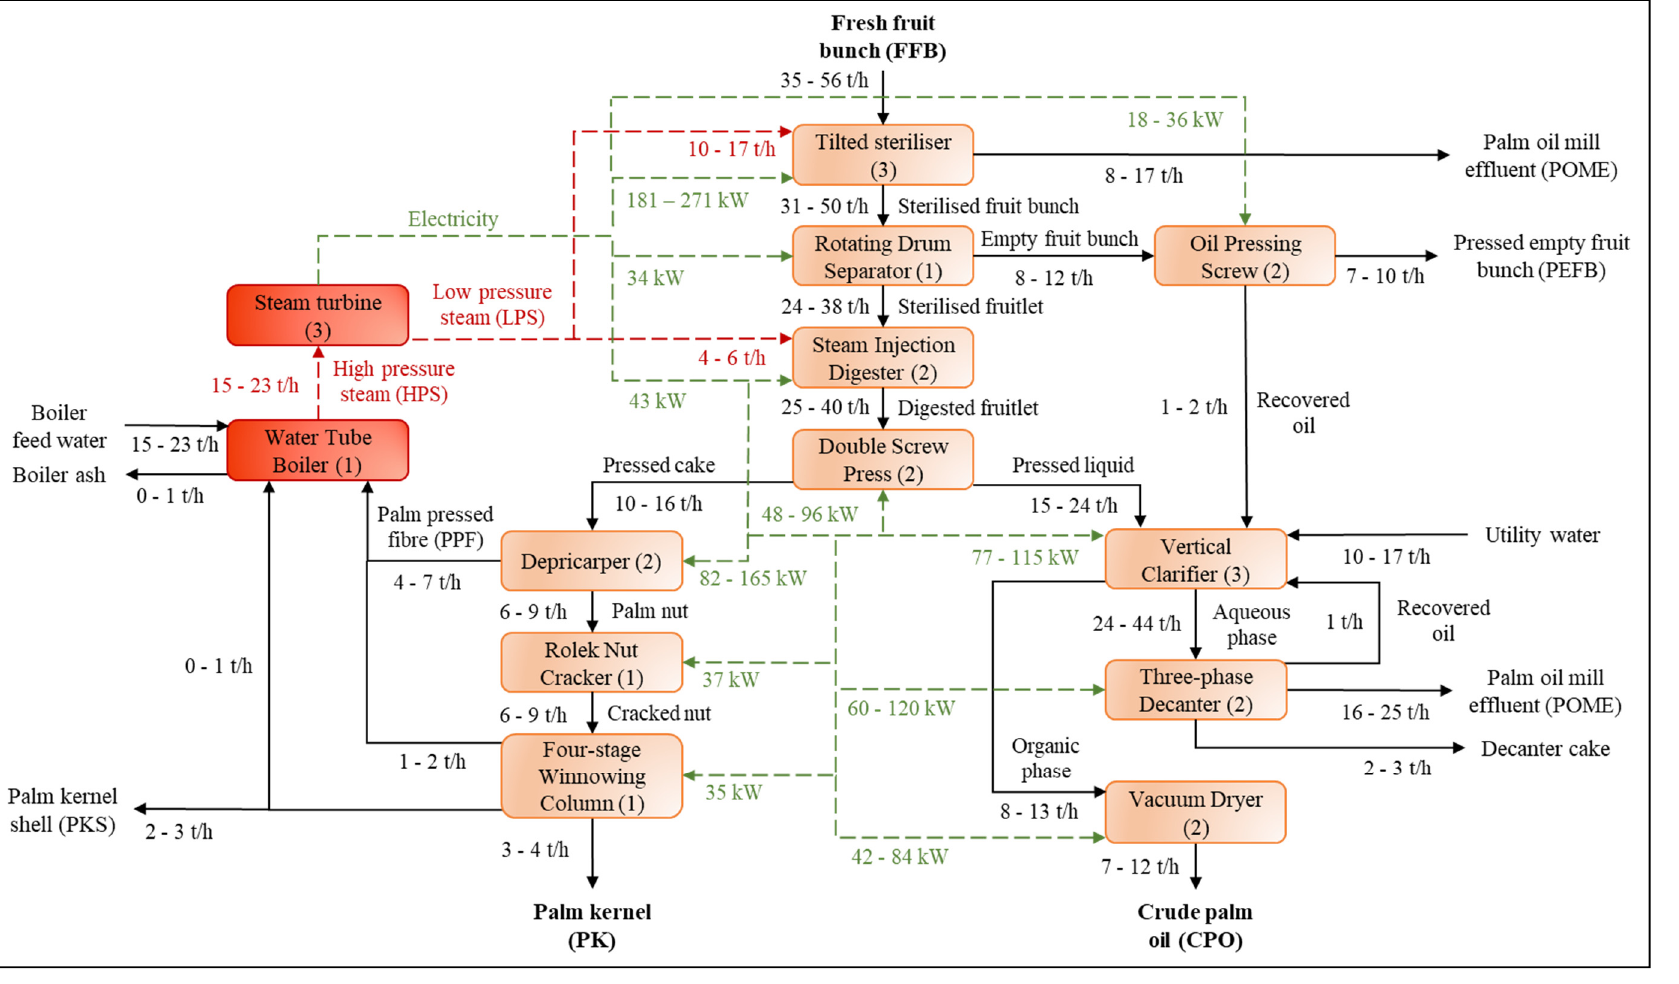
Figure 4. Optimised POM design.